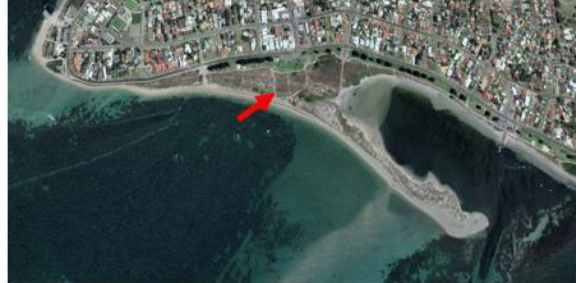
Figure 1. Warnbro Sound Study Site (Dec 2017). Image taken from Google Earth